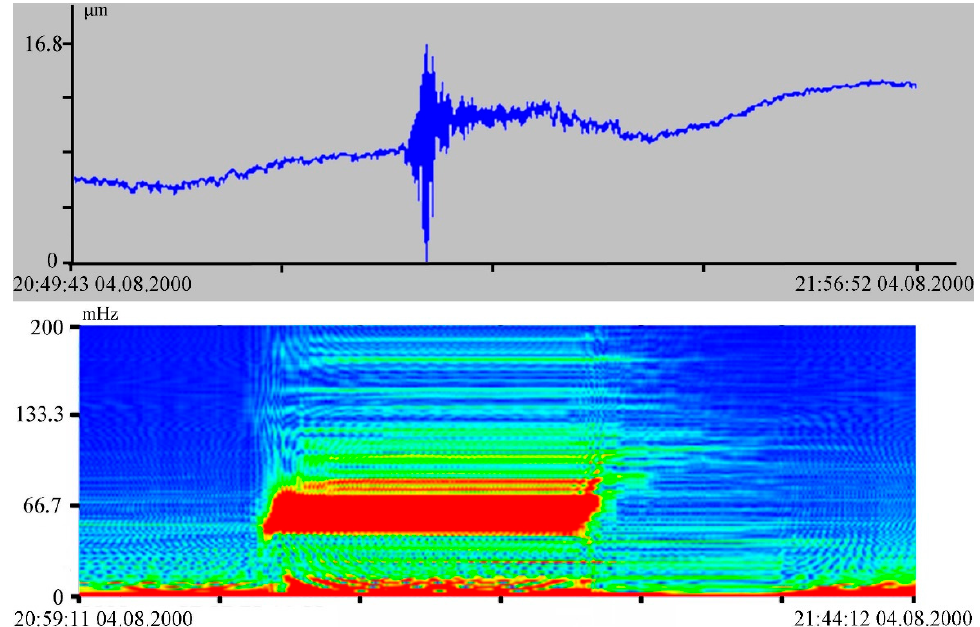
Figure 3. Fragment of the 52.5 m laser strainmeter recording from August 2000 ( top ) and a dynamic spectrogram of the laser strainmeter recording ( bottom ).